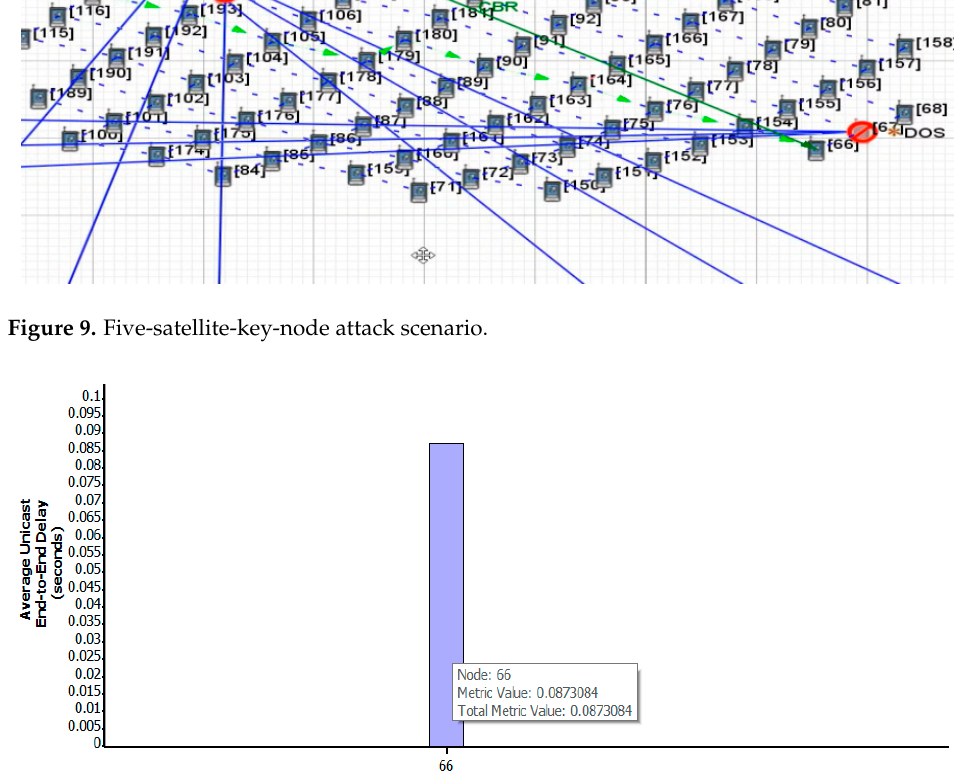
Figure 10. Average end-to-end delay under five-satellite-key-node attack scenario.